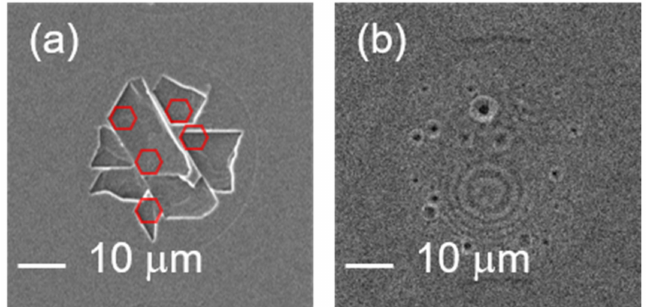
Figure 1. The one-pulse irradiated surface of ZnO ( a ) and Si ( b ) by a femtosecond laser with a wavelength of 1030 nm and pulse energy of 30 µ J. Corners with 120 ◦ angle randomly distributed in the one-pulse irradiated area are observed, which may be pieces from broken hexagon